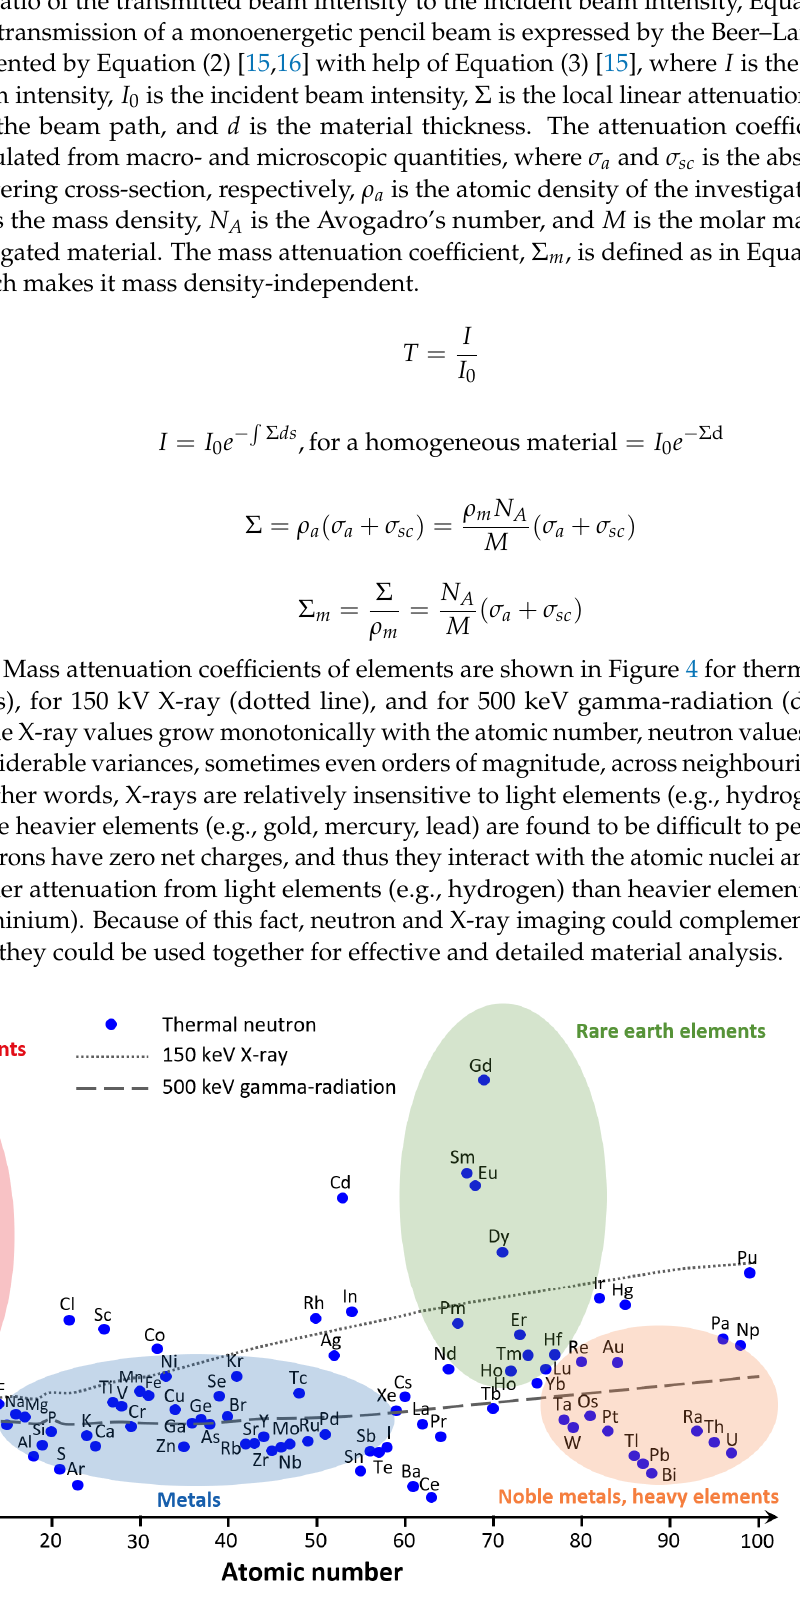
Figure 4. Mass a tt enuation coe ffi cients of elements on a logarithmic scale for di ff erent radiations. Figure 4. Mass attenuation coefficients of elements on a logarithmic scale for different